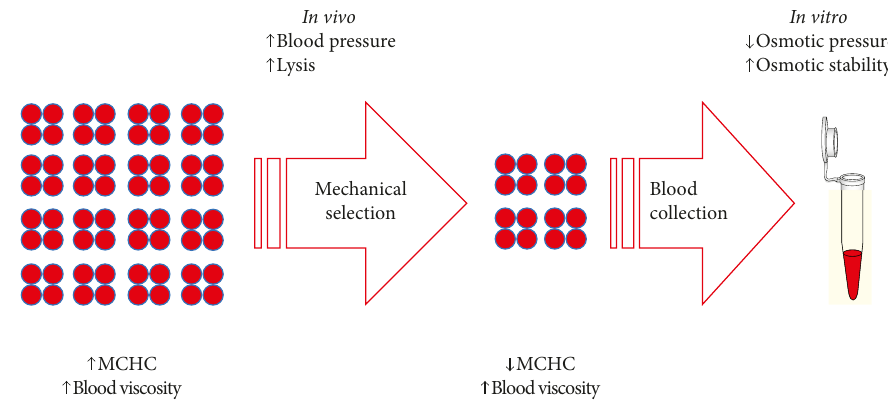
Figure 4: Mechanical selection and increased osmotic stability of erythrocytes in